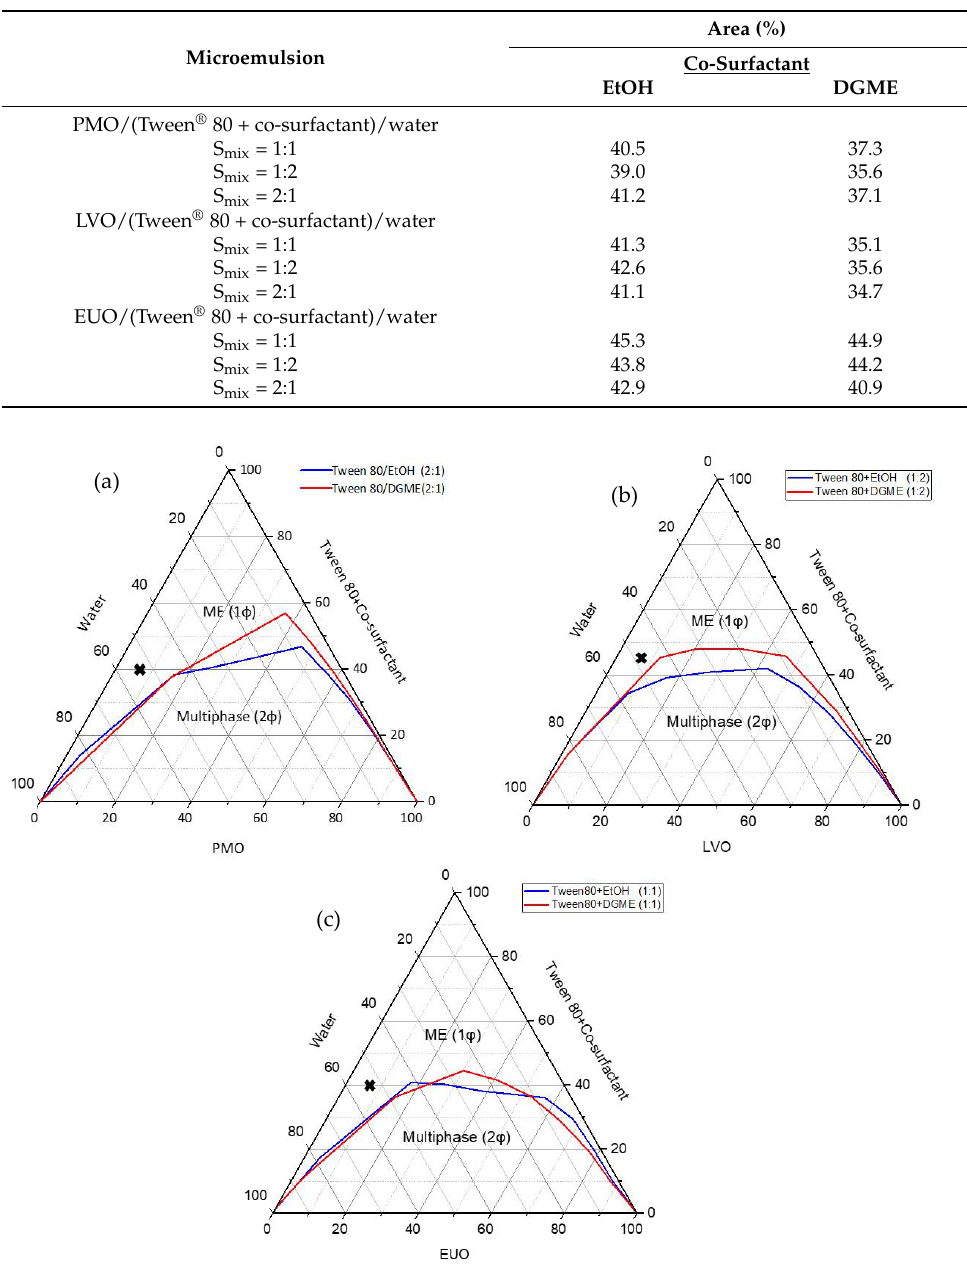
Figure 3. The pseudo-ternary phase diagrams of ( a ) PMO/(Tween ® 80 + co-surfactant (2:1))/water; ( b ) LVO/(Tween ® 80 + co-surfactant (1:2))/water; ( c ) EUO/(Tween ® 80 + co-surfactant (1:1))/water systems at room temperature. ME (1φ) represents single-phase ME region. The cross-marks shown in the pseudo-ternary phase diagrams represent the composition of selected microemulsions for preparing naringin-loaded microemulsions and microemulsion-gel